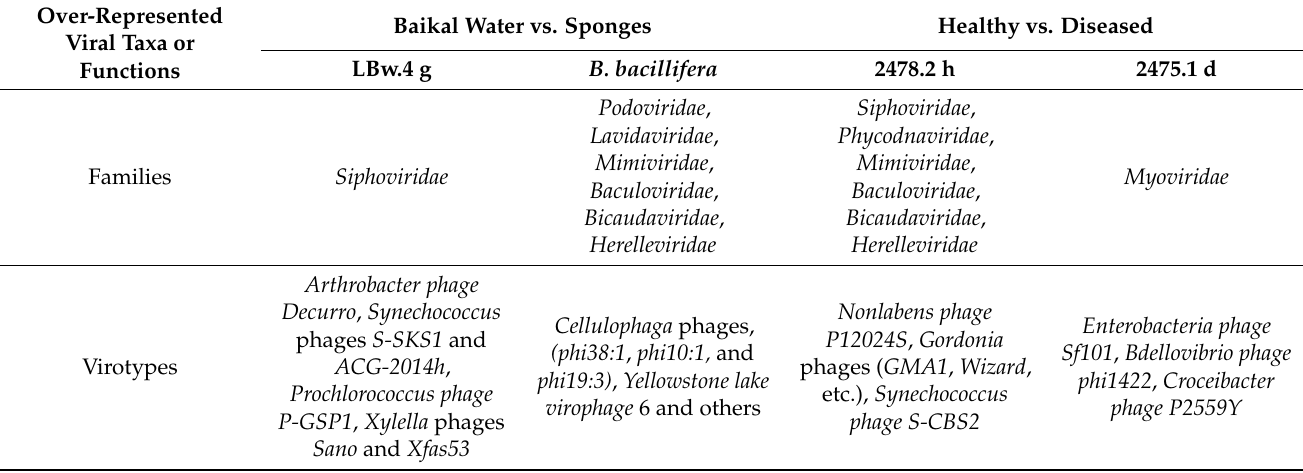
Figure 2. The taxonomic identification of viral sequences and putative hosts for revealed virotypes in the Baikal viromes: ( a ) the percentages of viral families; ( b ) heat maps demonstrating the distribution of 50 dominant virotypes in the samples (clustering was based on the Bray–Curtis distances); ( c ) the predicted viral hosts. Table 3. The main differences between diseased and healthy specimens of Baikal